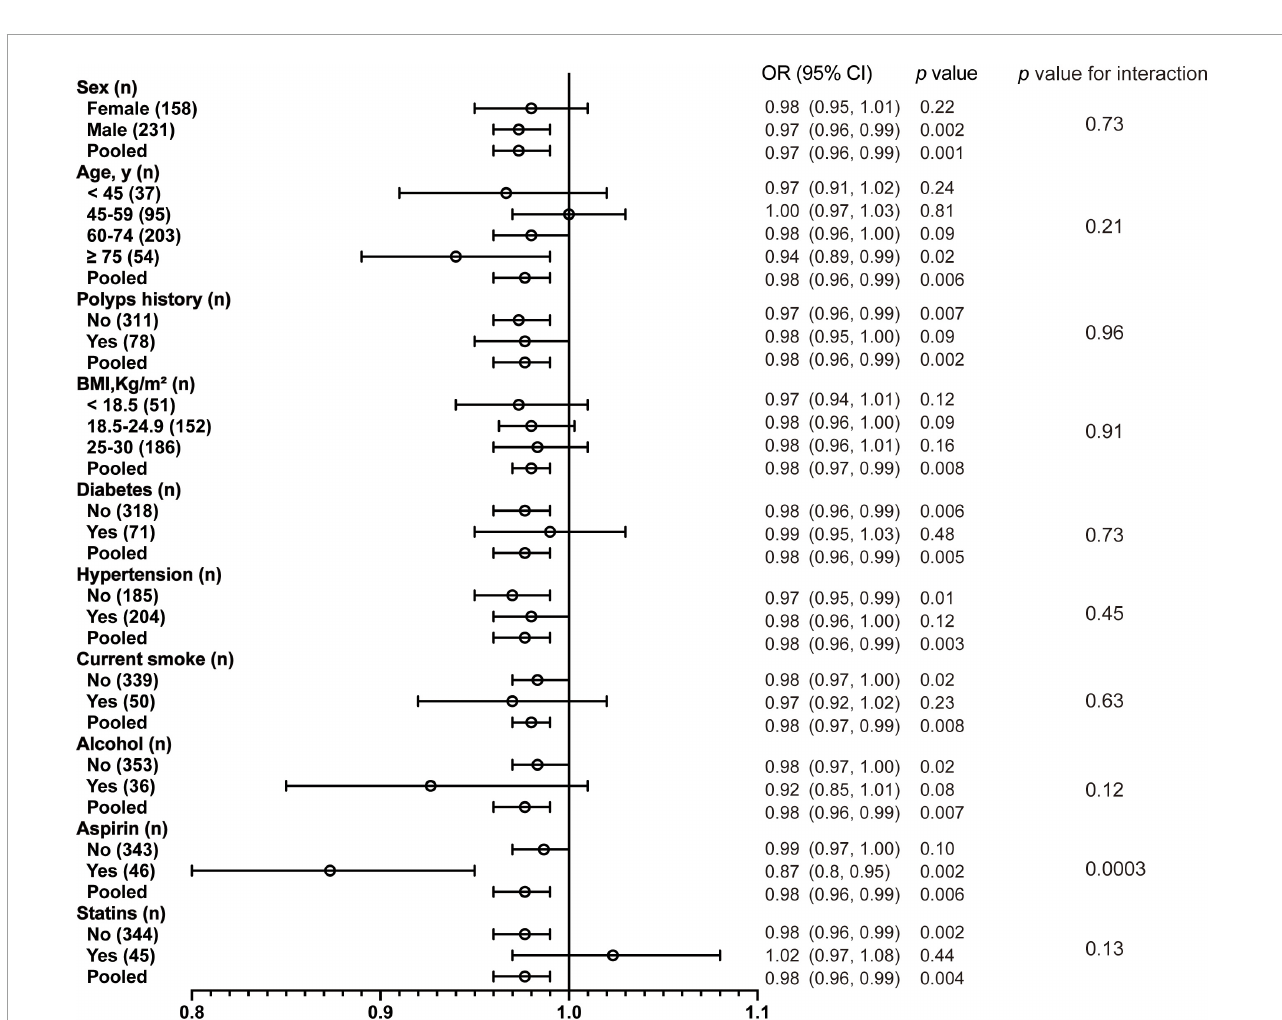
FIGURE2 Association between 25(OH)D per 10 nmol/L and CRC according to baseline characteristics. BMI, body mass index.